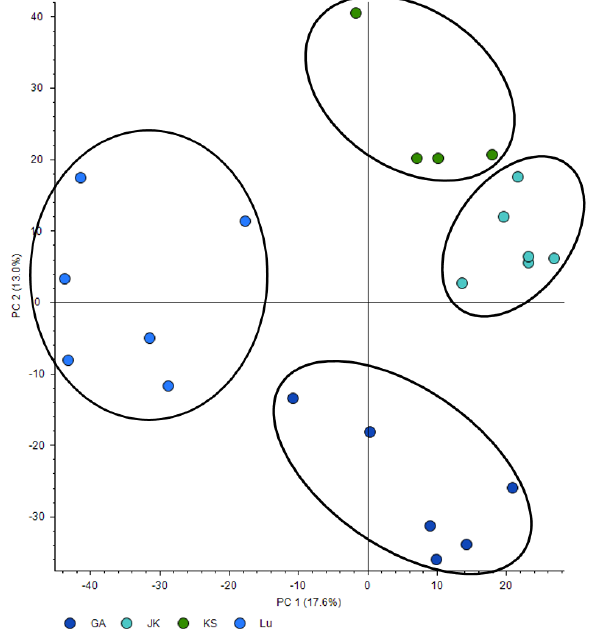
Figure 2. PCA score plot of HRMS-data of RW sampled from four DWTPs. Samples were collected bimonthly, and are in the figure labeled according to the city of DWTP. GA: Gävle, JK: Jönköping, KS: Karlstad, LU: Luleå. The results indicate that the profile of the organic compounds of the RW is unique to each supply studied. Percentages bracketed in axis legends are contribution ratios.